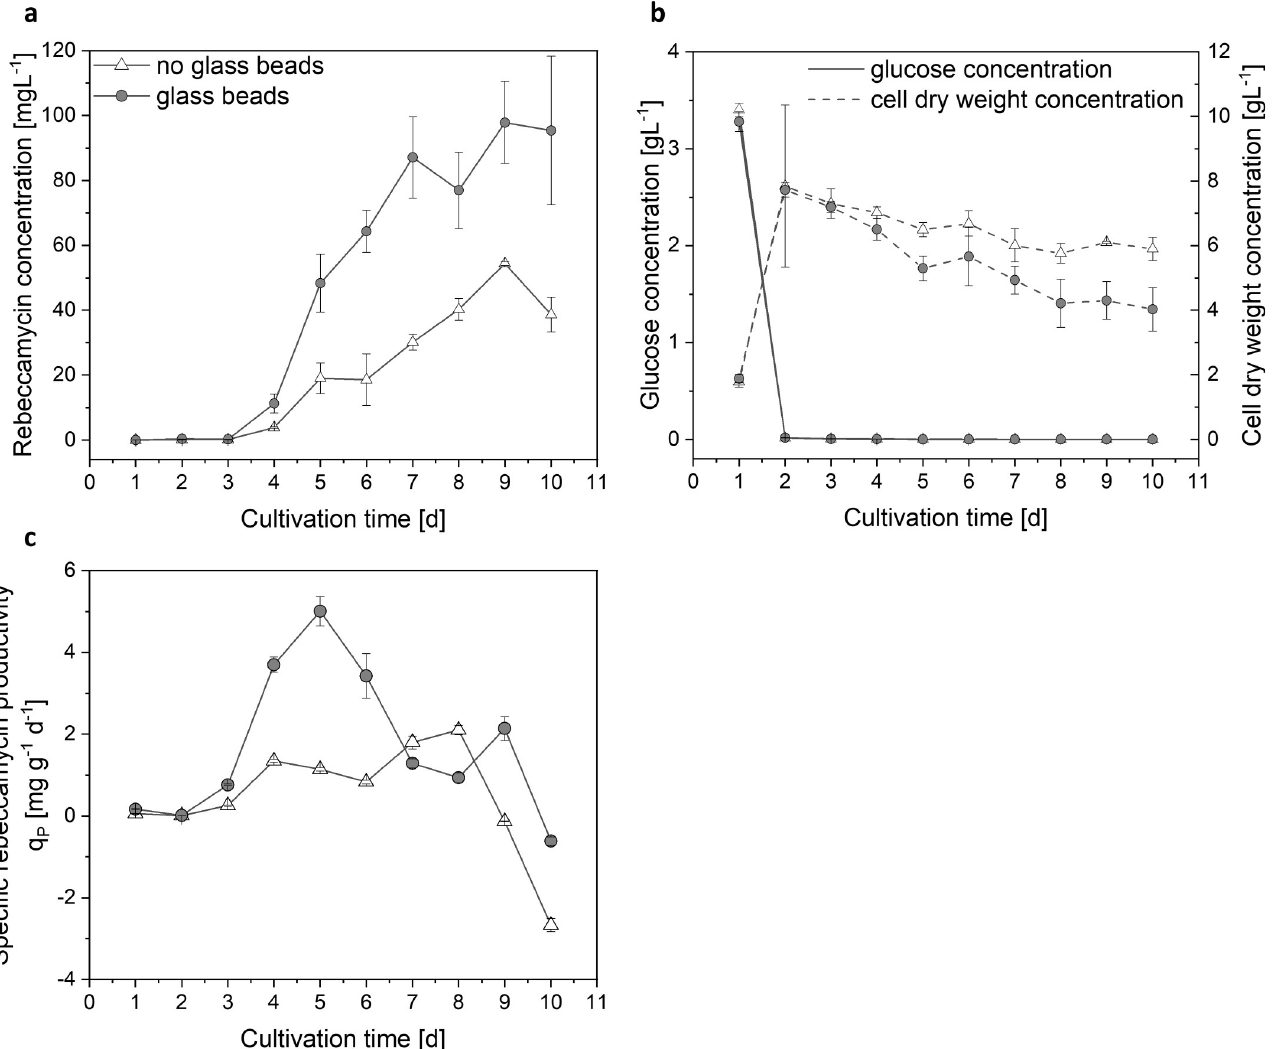
Fig 2. (a) Rebeccamycin, (b) glucose and cell dry weight concentrations and (c) specific rebeccamycin productivity q P of a 10 day cultivation of L . aerocolonigenes with (circle) and without (triangle) glass bead addition ( Ø = 969 μ m, 100 g L -1 ). Presented data are mean values with their respective standard